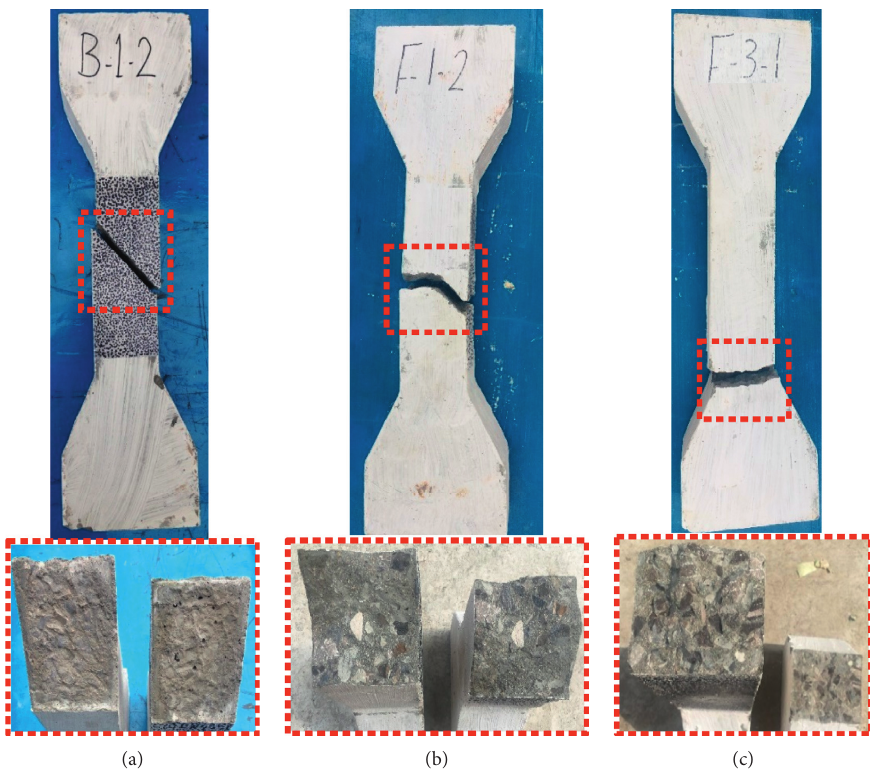
Figure 5: Failure modes. (a) Adhesive failure. (b) Partial adhesive failure. (c) Cohesive